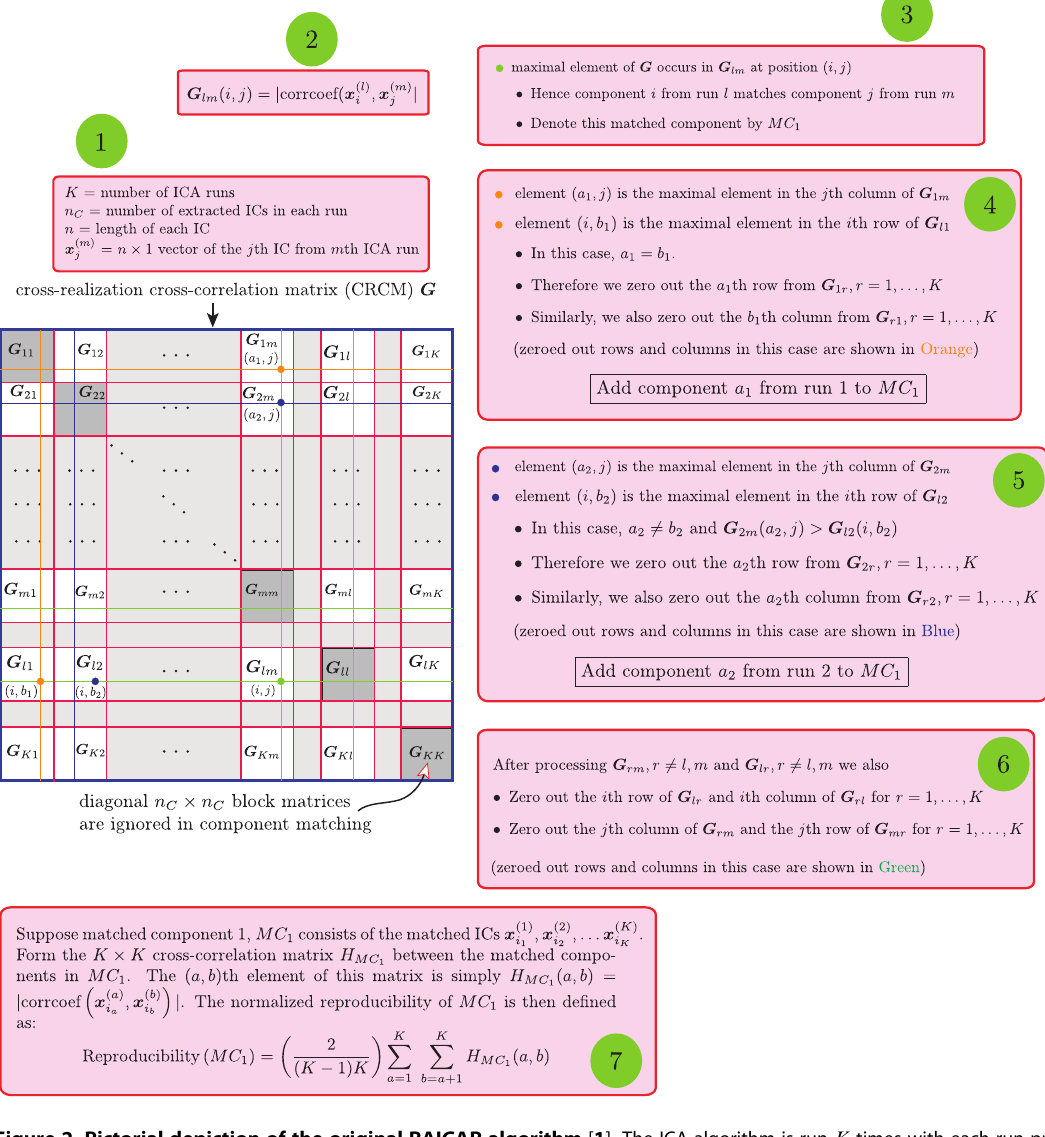
Figure 2. Pictorial depiction of the original RAICAR algorithm [ 1 ] . The ICA algorithm is run K times with each run producing n C ICs. G is a K | K block matrix with elements G ( l , m ) ~ G lm where G lm is the n C | n C absolute spatial cross-correlation matrix between ICs from runs l and m . The numbered green circles indicate the sequence of steps in applying RAICAR to a given data set. Our definition of normalized reproducibility in box 7 averages un-thresholded correlation coefficients thereby avoiding the selection of a correlation coefficient threshold prior to averaging.